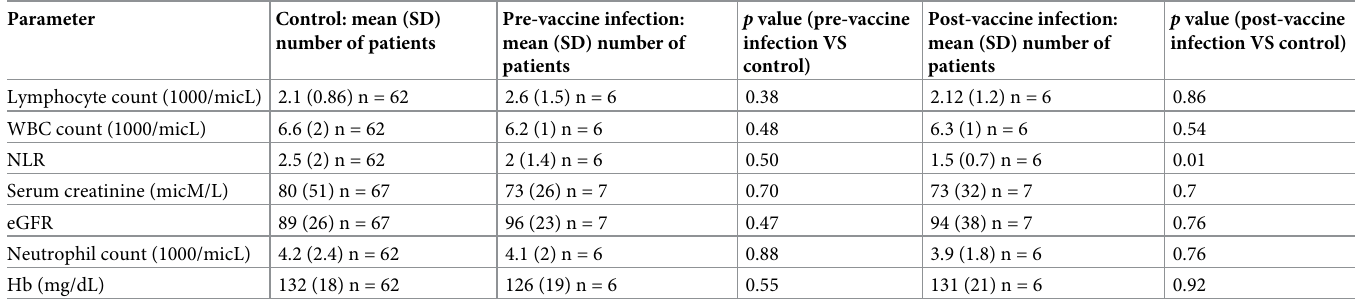
Table 3. Comparison of laboratory findings.